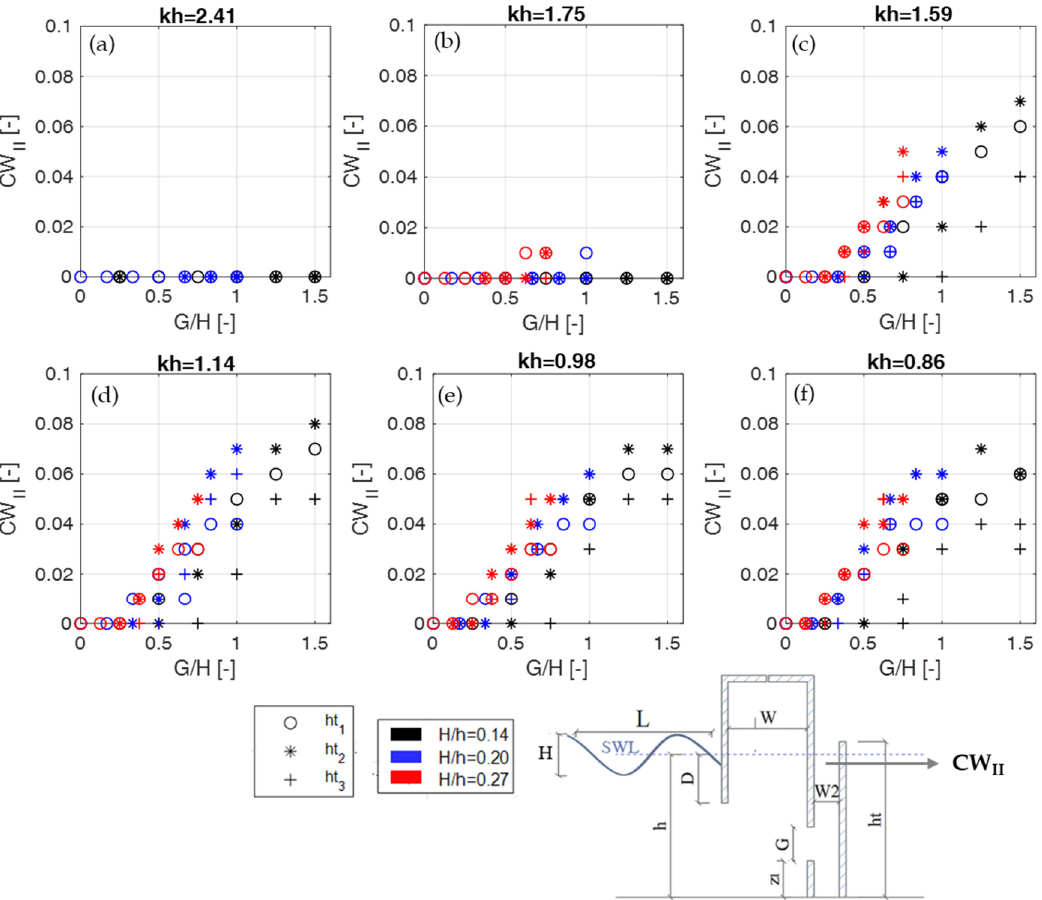
Figure 6. Capture width of the overtopping-based component of the device, CW II , as a function of the relative size of the submerged aperture G / H (where G is the size of the back-wall gap and H is the incident wave height) for different relative water depths: kh = 2.41 ( a ), 1.75 ( b ), 1.59 ( c ), 1.14 ( d ), 0.98 ( e ), 0.86 ( f ).